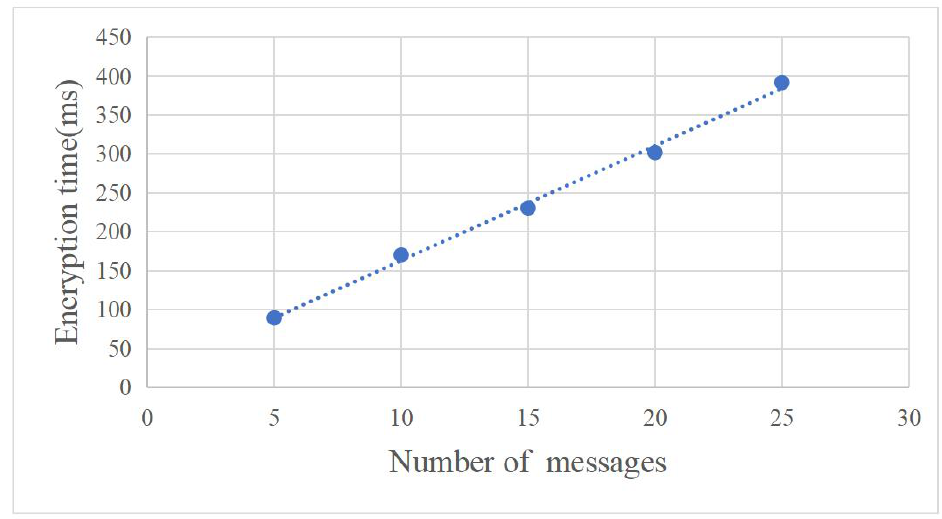
Figure 3. Encryption time according to messages.